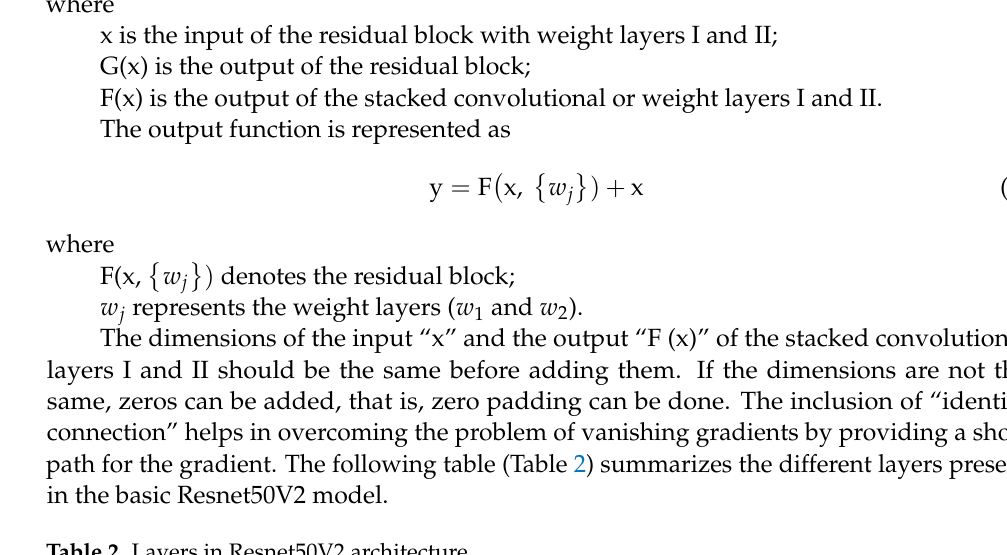
Table 2. Layers in Resnet50V2